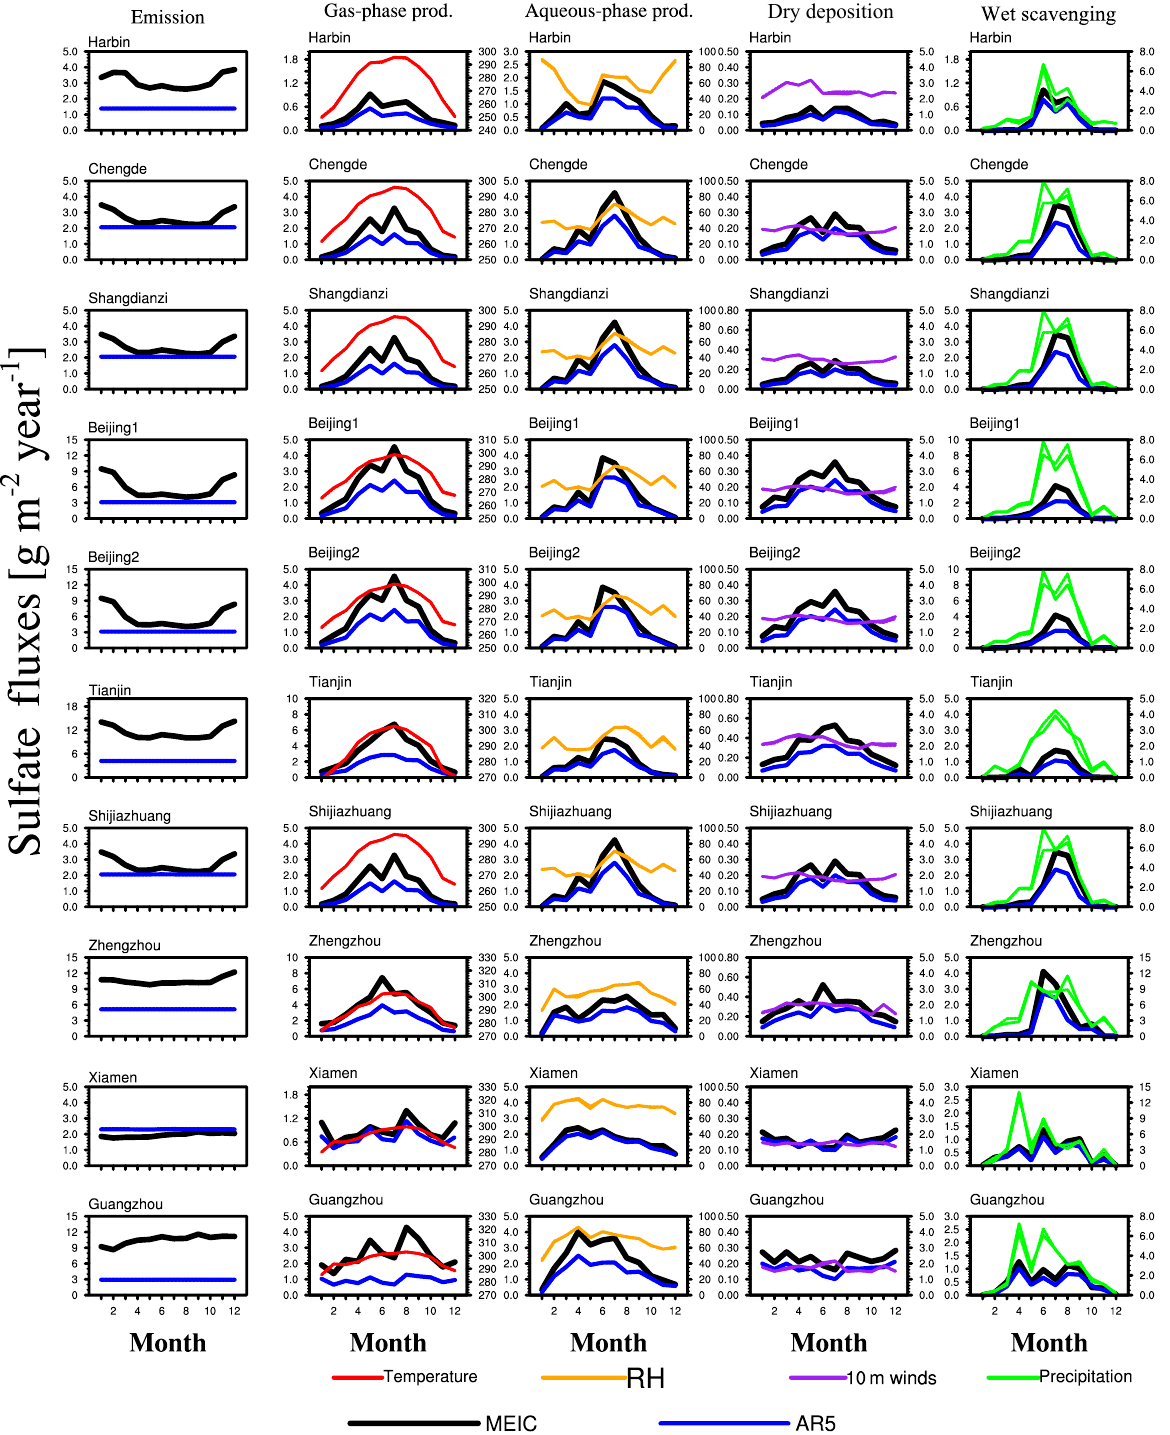
Figure 9. From left to right columns: (1) SO 2 emission rates from the MEIC (black) and the AR5 (blue) emission inventories, model simulations for the year 2009 of (2) gas-phase chemistry production rates in the simulations by MEIC and AR5 and the surface temperature (red), (3) aqueous-phase production rates and the relative humidity at the surface (yellow), (4) dry-deposition rates and the 10m wind speed (purple), and (5) wet-scavenging rates and the precipitation rate